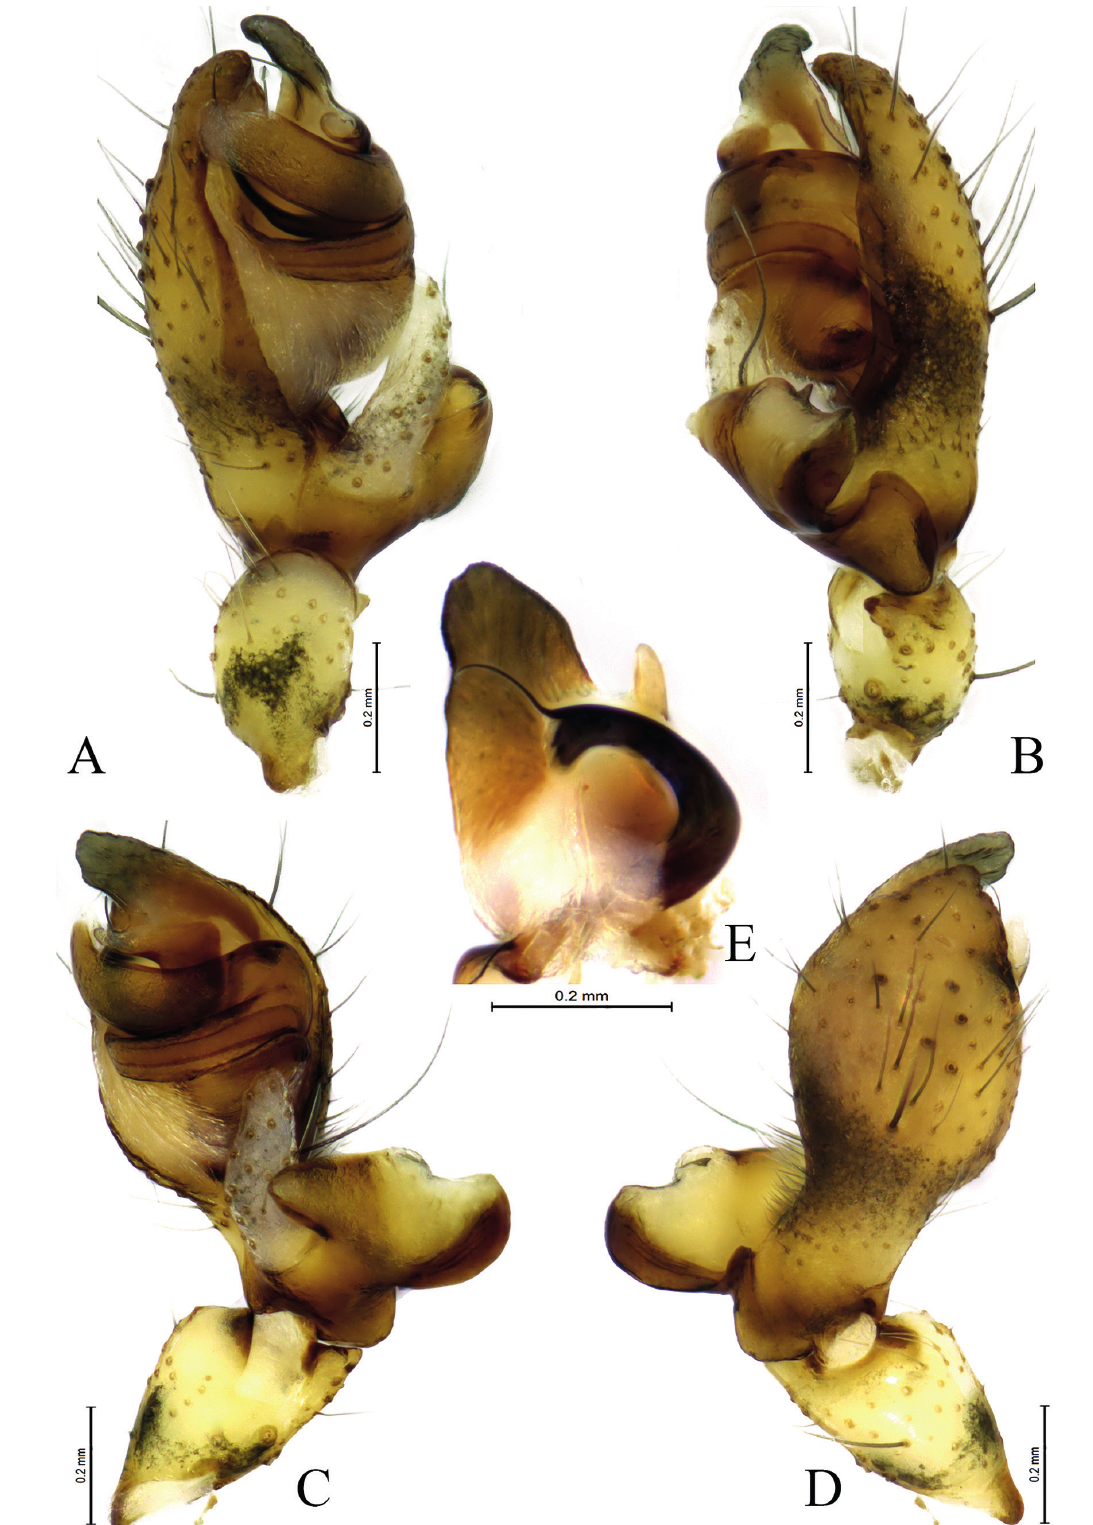
Fig. 3. Meta bowo sp. nov. A– D. ♂, holotype (SWUC-T-TEg-02-01). E . ♂, paratype (SWUC-T- TEg-02-02). A . Left palp, prolateral view. B . Same, ventral view. C . Same, retrolateral view. D . Same, dorsal view. E . Embolus and metaine embolic apophysis, dorsal